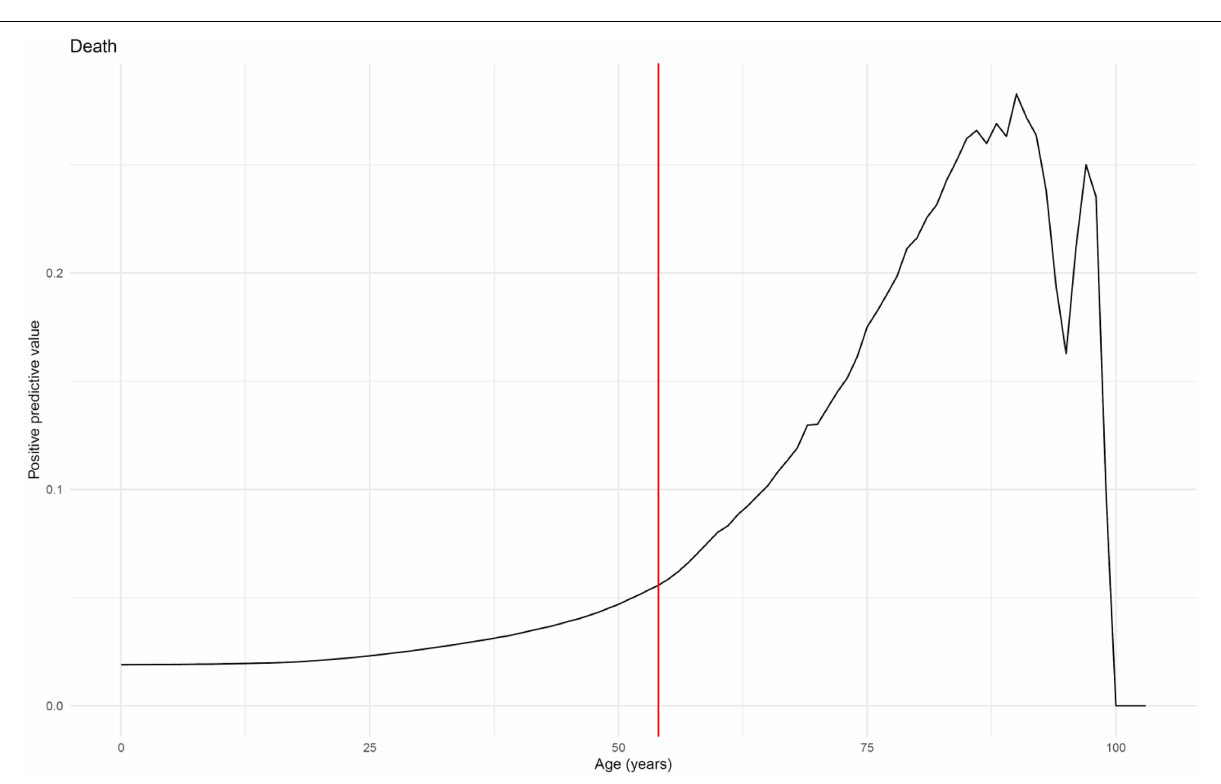
FIGURE 2 | Predictive value of age on death ( n = 14,960). Predictive value (probability of the event for ≥ age) is shown for death. Change points in the age related predictive values was determined by finding the multiple structural changes of the series’ linear model estimated by least-squares, using the method introduced by Bai and Perron (2003). We considered the first change point of the optimal partition of the series’ ascending part for detecting the significative predictive value acceleration. Optimal partitions of the ascending phases correspond to an acceleration at age 54.